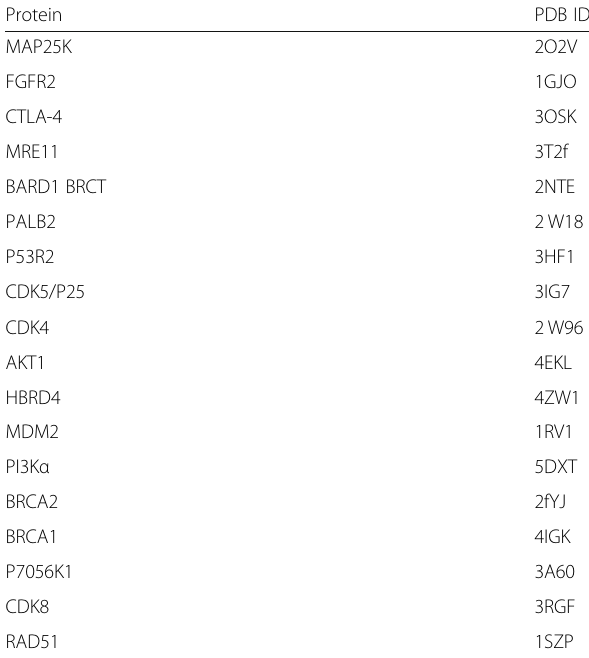
Table 1 Different proteins upregulated in BC and their respective PDB IDs